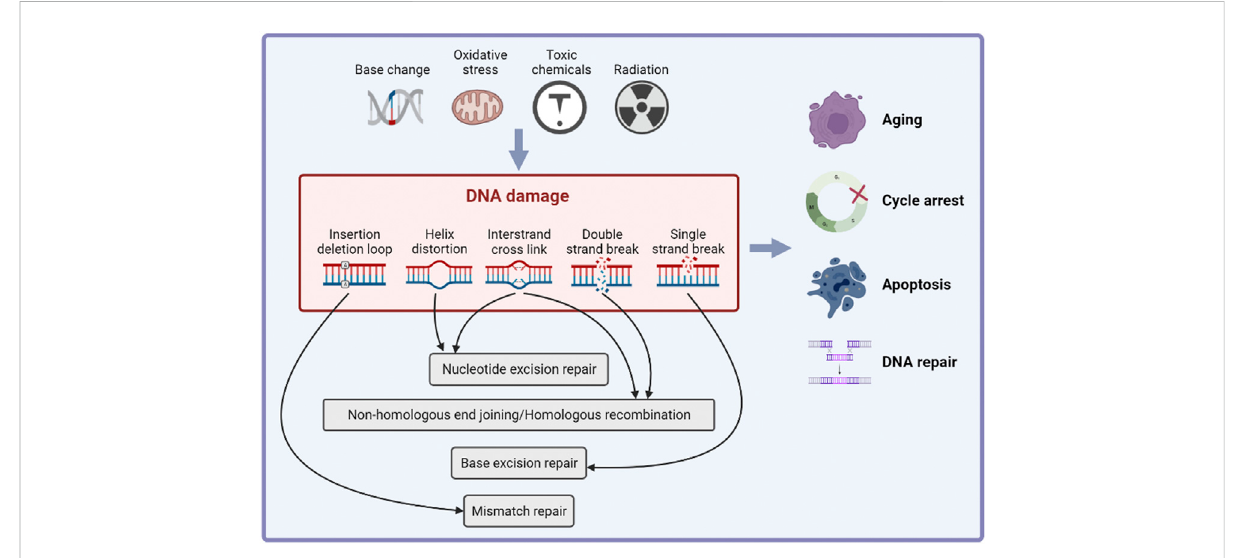
FIGURE 2 The inducements and effects of DNA damage response. Cells initiate a series of cascade reactions in response of endogenous of exogenous DNA damage inducements, whichis known as DNAdamage response (DDR). The main effects of DDRincludecell cyclearrest, apoptosis, aging and DNA